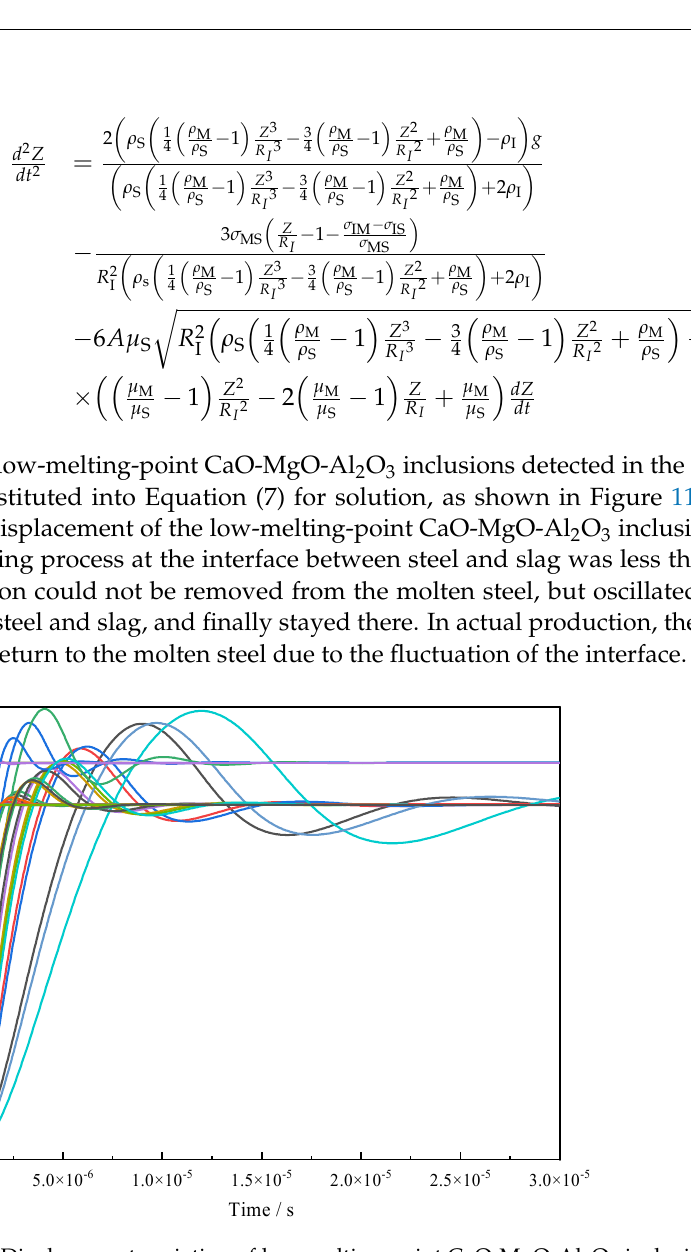
Figure 11. Displacement variation of low-melting-point CaO-MgO-Al 2 O 3 inclusions at the interface between steel and slag.